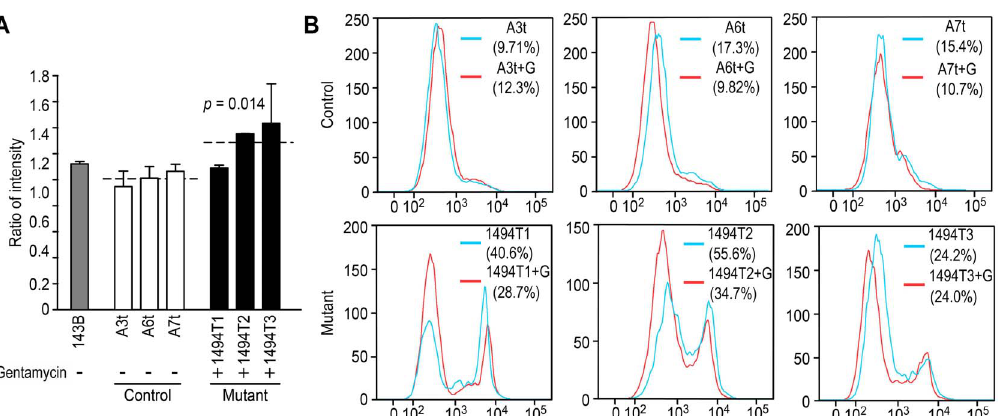
Figure 4. Cellular ROS and mitochondrial ROS production with or without gentamycin. (A) Ratios of the intensity (gentamycin-stimulated vs. non- stimulated) of cellular ROS in 143B.TK 2 cells (grey column), three control cybrids containing wild-type mtDNA (A3t, A6t & A7t, white columns) and three m.1494C . Tcybrids (1494T1/T2/T3, black column). Cells were analyzed with the FC500MCL flow cytometer system (Beckman) using DCFDA (20 m M). (B) Mitochondrial ROS detection using MitoSOX (5 m M) in three control cybrids (A3t, A6t and A7t) and three m.1494C . Tcybrids (1494T1/T2/T3), either without (blue) or with (red) gentamycin stimulation. Fluorescence was measured with FACSCalibur (BD Biosciences), and analyzed using FlowJo